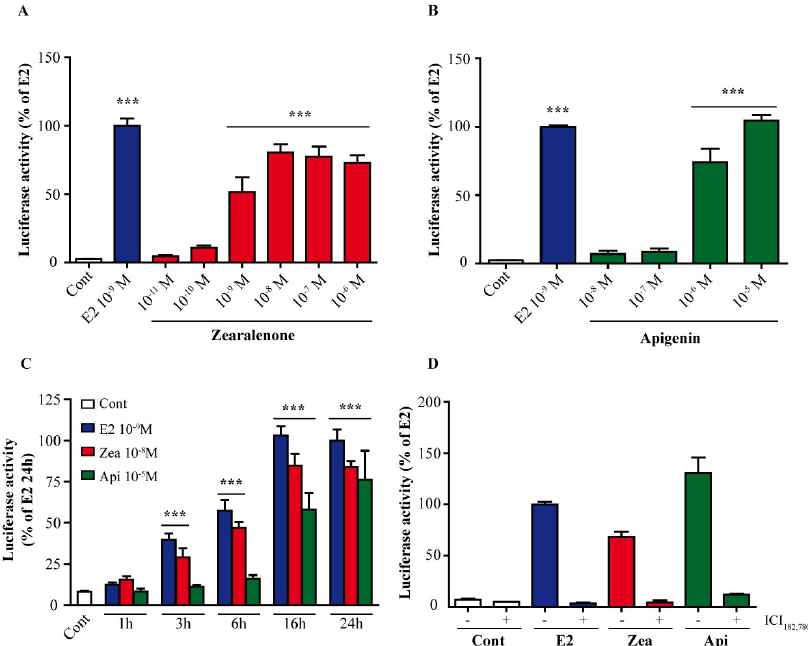
Figure 1. Effect of zearalenone and apigenin on estrogen receptor (ER) activation. MCF-7 cells were transfected with an estrogen-responsive element-thymidine kinase (ERE-TK)-luciferase reporter plasmid and a cytomegalo virus (CMV)- β galactosidase plasmid as a control for transfection efficiency. Then, cells were treated with solvent as a negative control (white), 10 − 9 M E2 as a positive control (blue) or various doses of zearalenone (red) ( A ) or apigenin (green) ( B ) for 24 h. The results are expressed as the percentage of luciferase activity attained with E2 treatment and are the means ± standard error of the mean (SEM) of three to four independent experiments. Cells were treated with solvent as a negative control (white), 10 -9 M E2 as a positive control (blue), 10 − 8 M zearalenone (red) or 10 − 5 M apigenin (green) for 1 h, 3 h, 6 h, 16 h and 24 h ( C ). The results are expressed as the percentage of luciferase activity attained with E2 treatment at 24 h and are the means ± SEM of three independent experiments. ( D ) To confirm the estrogenic effects of apigenin and zearalenone, transfected cells were cotreated with 10 − 6 M ICI 182,780 and either 10 − 9 M E2 (blue) or 10 − 8 M zearalenone (red) or 10 − 5 M apigenin (green). *** indicates a p -value < 0.001 by one-way analysis of variance (ANOVA) followed by Dunnett’s post hoc test for comparison of the control treatment with the other